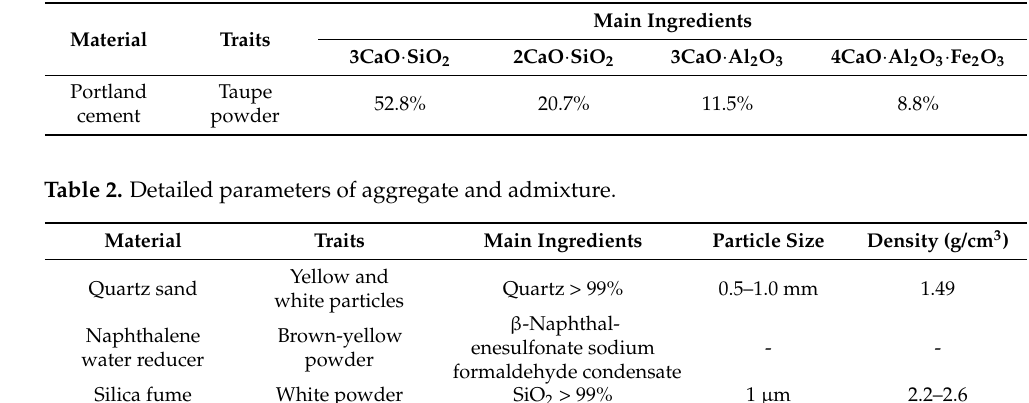
Table 1. Chemical composition of Portland cement.